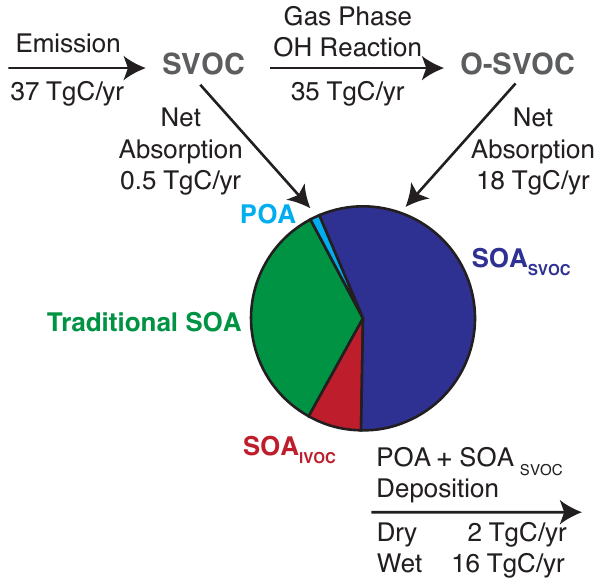
Fig. 4. SVOC budget. Relative portions of pie indicate annual net production (32TgC/yr total). SVOC and O-SVOC (oxidized SVOC) are also wet and dry deposited (not shown). All numbers are for year 2000. Simulation performed at 2 ◦ × 2 . 5 ◦ with GEOS-4